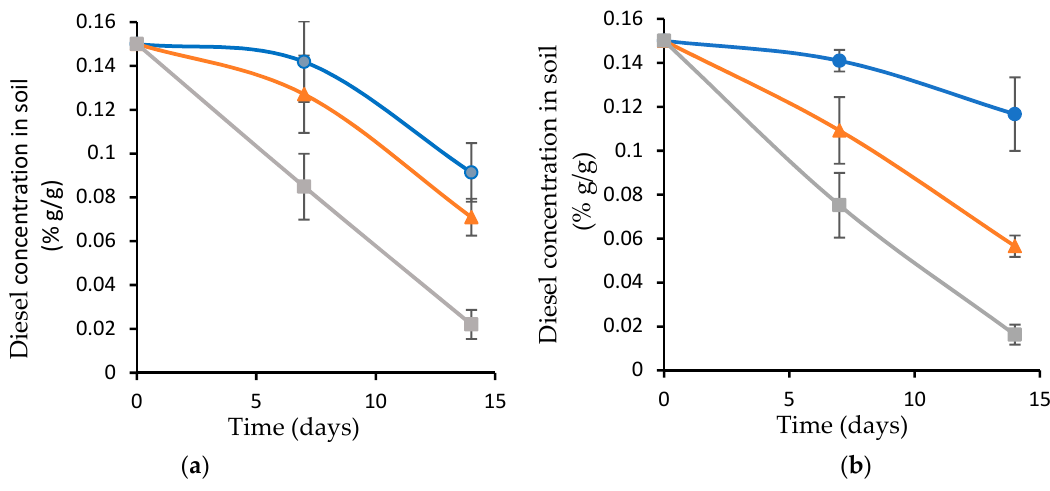
Figure 6. Diesel concentration as a function of soil acidity, pH 5 (a) and pH 8 (b). Soil that was inoculated with the plasma-treated wood waste covered with biofilm (grey); untreated wood waste covered with biofilm (orange); and planktonic bacteria (blue).